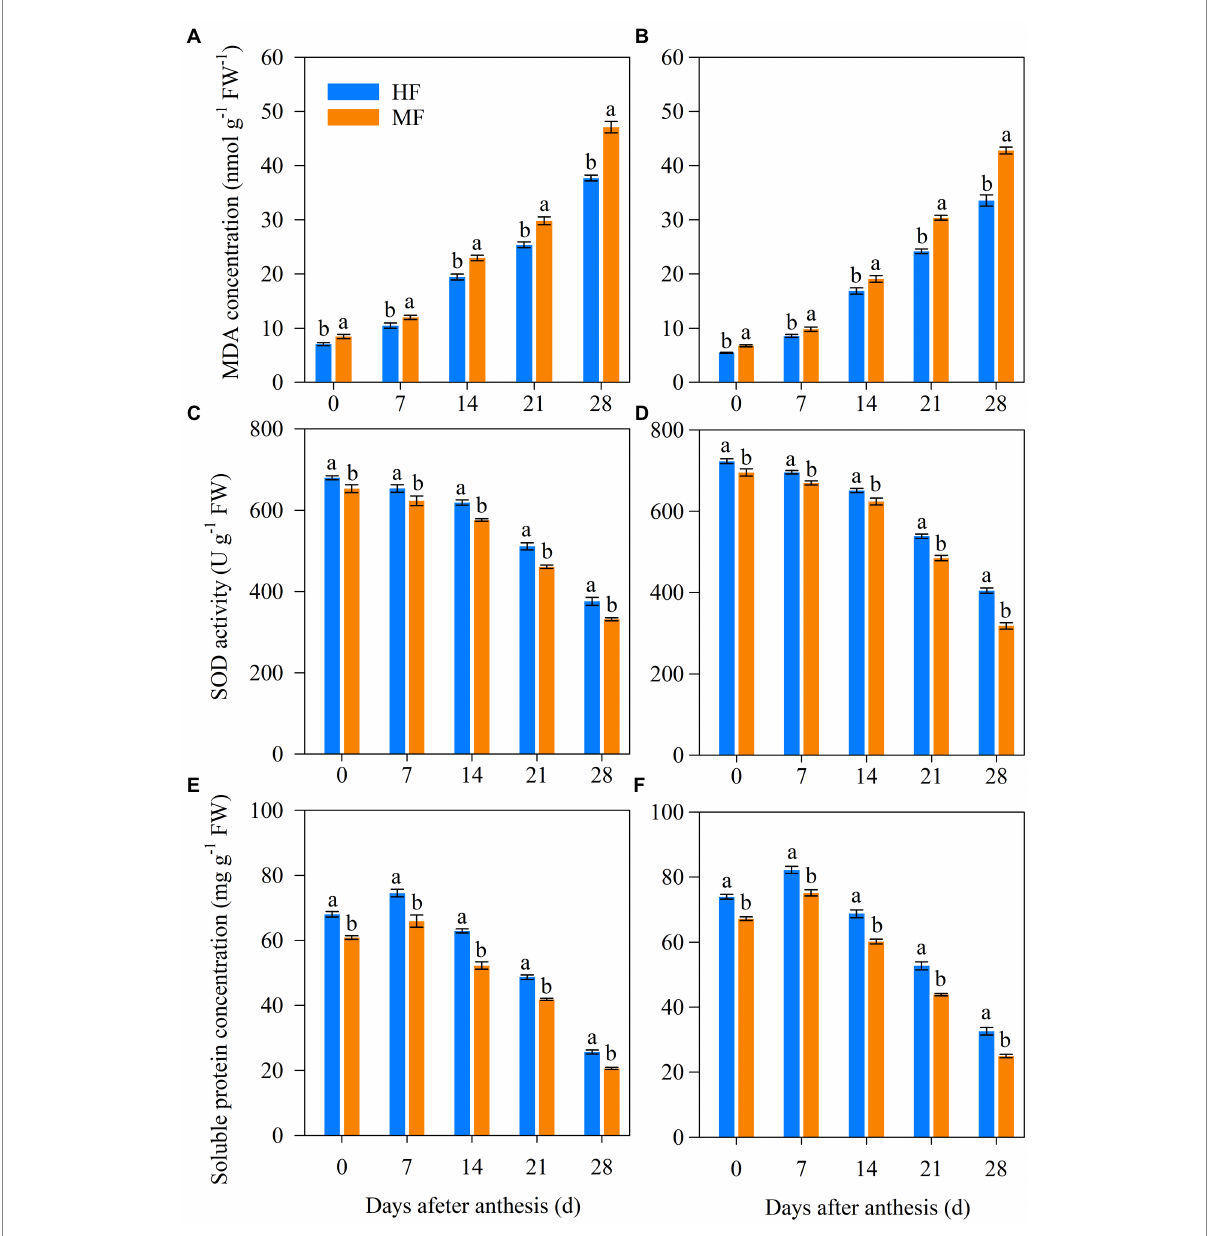
FIGURE 5 Malondialdehyde (MDA) concentration, superoxide dismutase (SOD) activity, and soluble protein (SP) concentration of flag leaves after anthesis in 2017/18 (A,C,E) and 2018/19 (B,D,F) growing seasons. HF, high soil fertility field and MF, middle soil fertility field. Vertical bars represent SD of the means. Different letters indicate statistical significance at p < 0.05 among